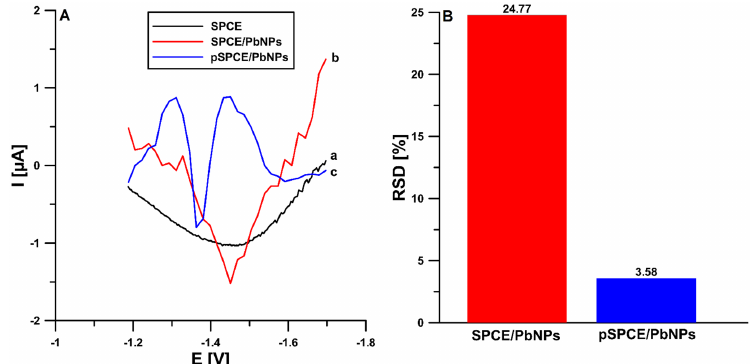
Figure 2. ( A ) DPAdSV curves of 2 × 10 − 9 mol L − 1 TST recorded at the unmodified SPCE ( a ), modified with PbNPs ( b ), and the electrochemically pretreated SPCE/PbNPs ( c ). ( B ) Histogram bars of the repeatability of the TST signal (relative standard deviation (RSD), 2 × 10 − 9 mol L − 1 TST, n = 10) at the SPCE/PbNPs and pSPCE/PbNPs. The interfacial electron transport ability of the unmodified SPCE and the electrochemically pretreated SPCE/PbNPs was studied using EIS and CV techniques in 0.1 mol L − 1 KCl containing 5.0 mmol L − 1 K 3 (Fe(CN) 6 ). The CV curve displayed a pair of well-defined redox peaks of (Fe(CN) 6 ) 3-/4- at the unmodified SPCE (Figure 3A, curve a). In the case of the pSPCE/PbNPs (Figure 3A, curve b), the peak-to-peak separation ( Δ E) increases from 123.6 to 169.0 mV, which is ascribed to the inhibition of the electrochemical reaction process by the PbNPs modification and electrochemical pretreatment. Moreover, the rate of the electron transfer at the SPCE and the pSPCE/PbNPs was calculated as the relative peak separations ( χ 0 ) by dividing Δ E by 59 mV. The χ 0 values for the SPCE and pSPCE/PbNPs were greater than the theoretical value ( χ 0 = 1) and were equal to 2.09 and 2.86, respectively. Furthermore, the pSPCE/PbNPs show a higher anodic current intensity than the SPCE. The new peak at a potential around − 0.5 V is related to the oxidation of lead from the pSPCE/PbNPs surface. The obtained results indicate that the PbNPs modification and electrochemical pretreatment inhibit the electron transfer kinetics. In addition, the Randles–Sevcik equation, CV curves recorded at scan rates of 5–150 mV s − 1 , and the dependence between the anodic peak current (I p ) and the square root of the scan rate (v 1/2 ) (Figure 3B) were used to calculate of the electrochemically active electrode area (A s ) of the SPCE and pSPCE/PbNPs [44]. The A s values of the SPCE and pSPCE/PbNPs were calculated to be 0.072 and 0.22 cm 2 , respectively. It is evident that the PbNPs modification and electrochemical pretreatment significantly increase the A s . Moreover, the impedance spectra (Nyquist plots) were recorded at the SPCE and pSPCE/PbNPs in the frequency range from 50 kHz to 1 Hz (Figure 3C). According to the experimental results, the charge transfer resistance (R ct ) values obtained for the SPCE and pSPCE/PbNPs are 146.7 and 121.3 Ω , respectively. The pSPCE/PbNPs are characterized by lower R ct and good conductivity.